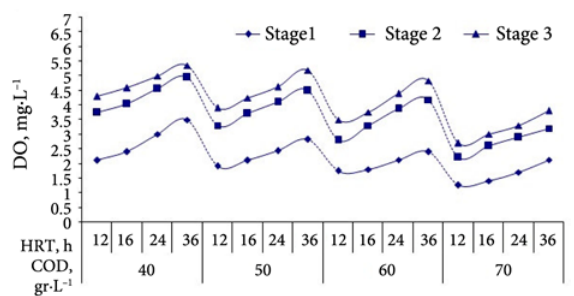
Fig. 2. DO level with respect to HRT and COD in different stages